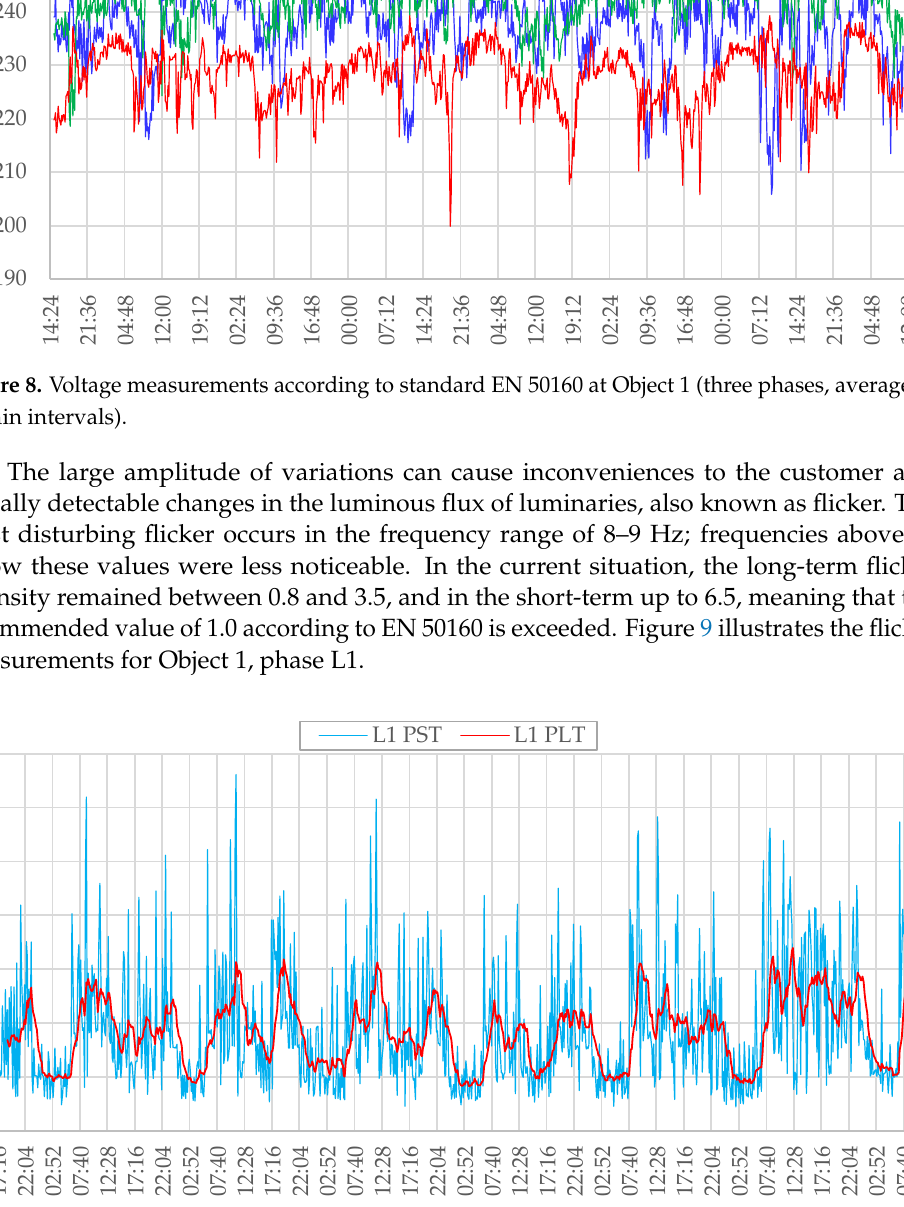
Figure 9. Flicker values for Object 1 in phase L1, according to standard EN 50160–PST in 10-min interval and PLT in 2-h average intervals (allowed limit <1.0 95% of the time).